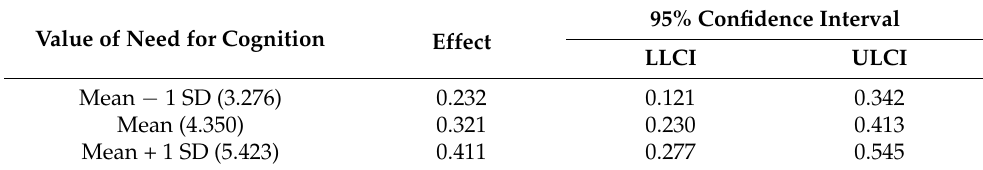
Table 4. Conditional effect of personalization quality on empathy at value of need for cognition.